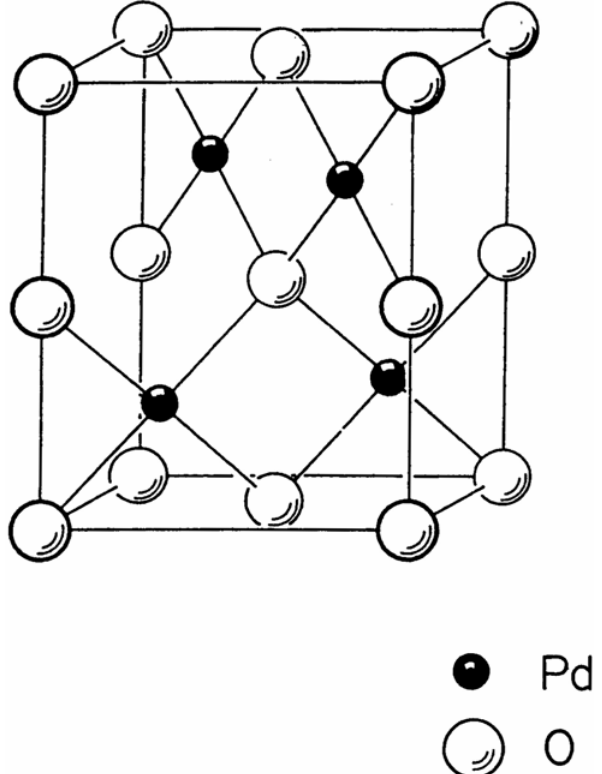
Figure 7. Cooperite